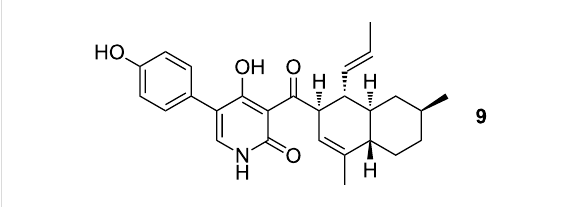
Figure 3: Ilicicolin H as an example of a 3-decalinoyl-4-hydroxypyridin- 2-one metabolite.